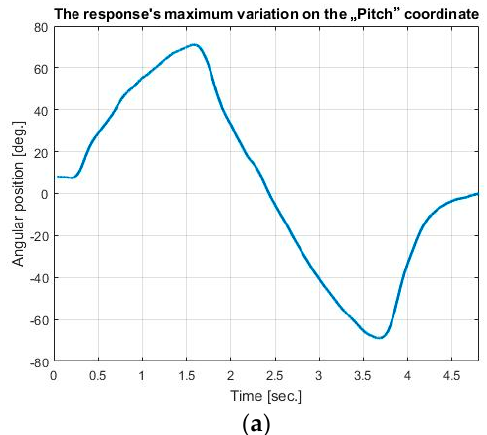
Figure 9. Raw measured output for the three degree of freedom.